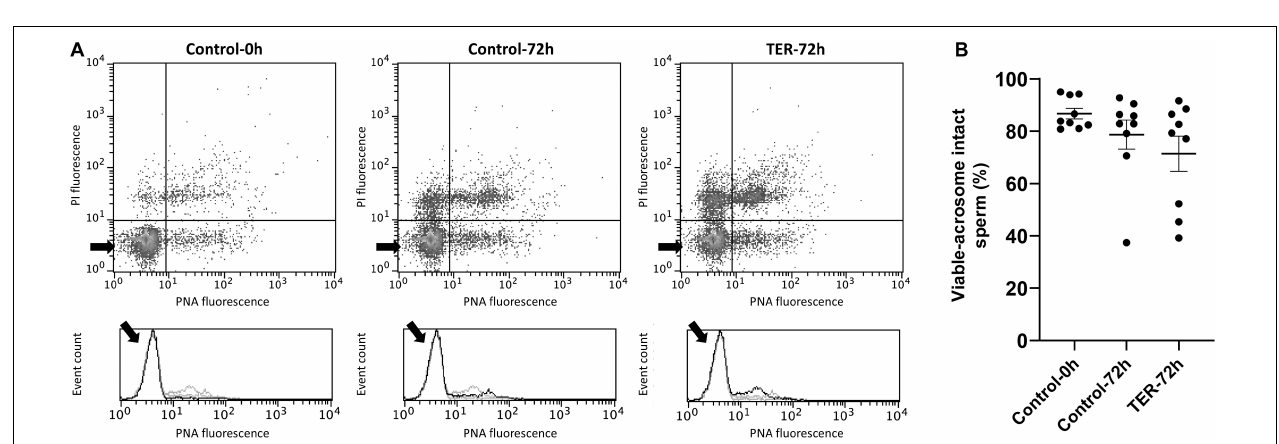
FIGURE 10 | Flow cytometry analysis of acrosome integrity. (A) Representative flow cytometry dot plots of propidium iodide (PI) and fluorescein-conjugated peanut agglutinin/propidium iodide (PNA) fluorescence and histograms showing the event count of PNA fluorescence intensity of all treatments. Black arrows show the flow cytometry population selected for analysis represented in (B) . Dark gray lines in histograms show the event count of its corresponding treatment, whereas light gray lines show the event count of the remaining treatments. (B) Mean, standard error of the mean (SEM), and sample distribution of the percentage of viable sperm with an intact acrosome in all treatments. Control-0h, semen samples at 0 h of storage; Control-72h, vehicle control (dimethyl sulfoxide; DMSO) semen samples at 72 h of storage at 17 ◦ C; TER-72h, semen samples treated with 100 µ M ezatiostat (TER) for 72 h of storage at 17 ◦ C. Sample size ( n = 9). p >